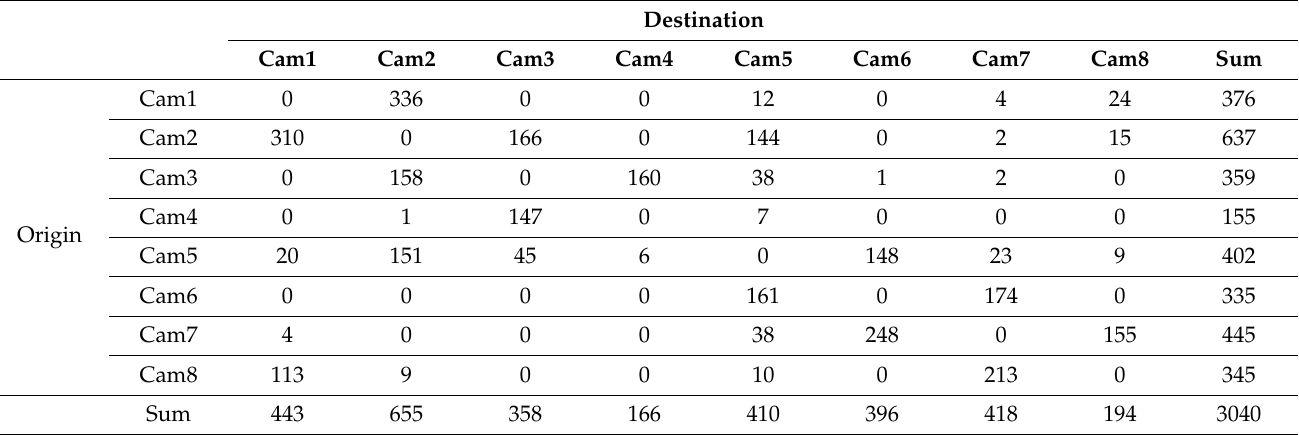
Table 3. Origin–destination (O–D)